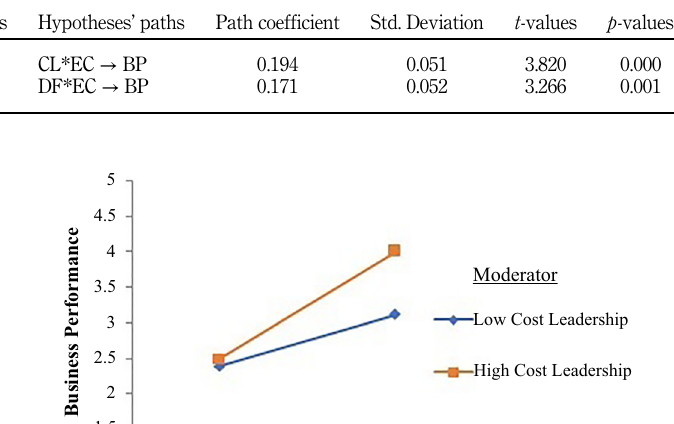
Figure 2. Moderating effect